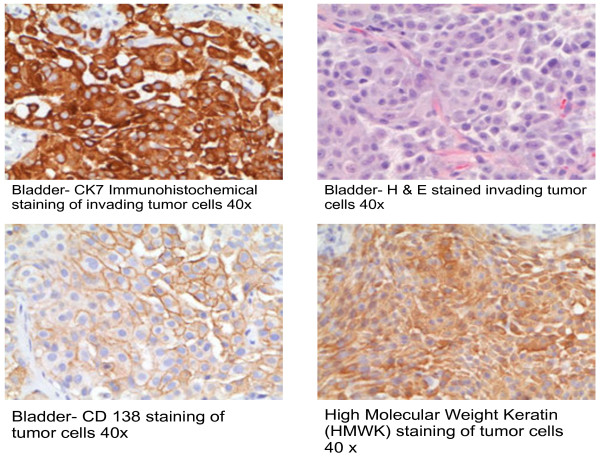
Bladder Mass Biopsy.